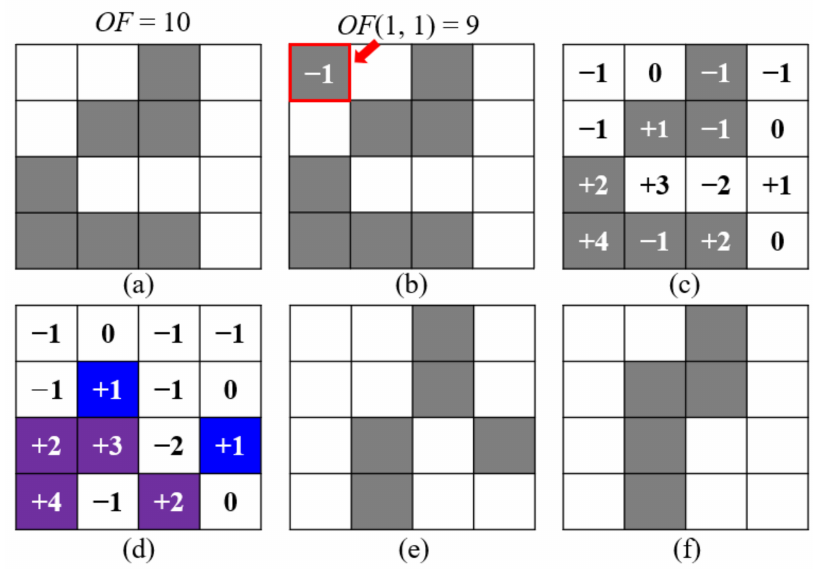
Figure 9. An example to explain the ON-OFF method. ( a ) Initial shape (objective function value = 10); ( b ) A shape in which one cell is inverted (objective function value = 9); ( c ) Initial model with expected gains; ( d ) Model showing cells with positive expected gains (purple: large gain, blue: small gain); ( e ) A model inverted cell with low expected gain; ( f ) A model that reversed only the cell, which is a large expected benefit.